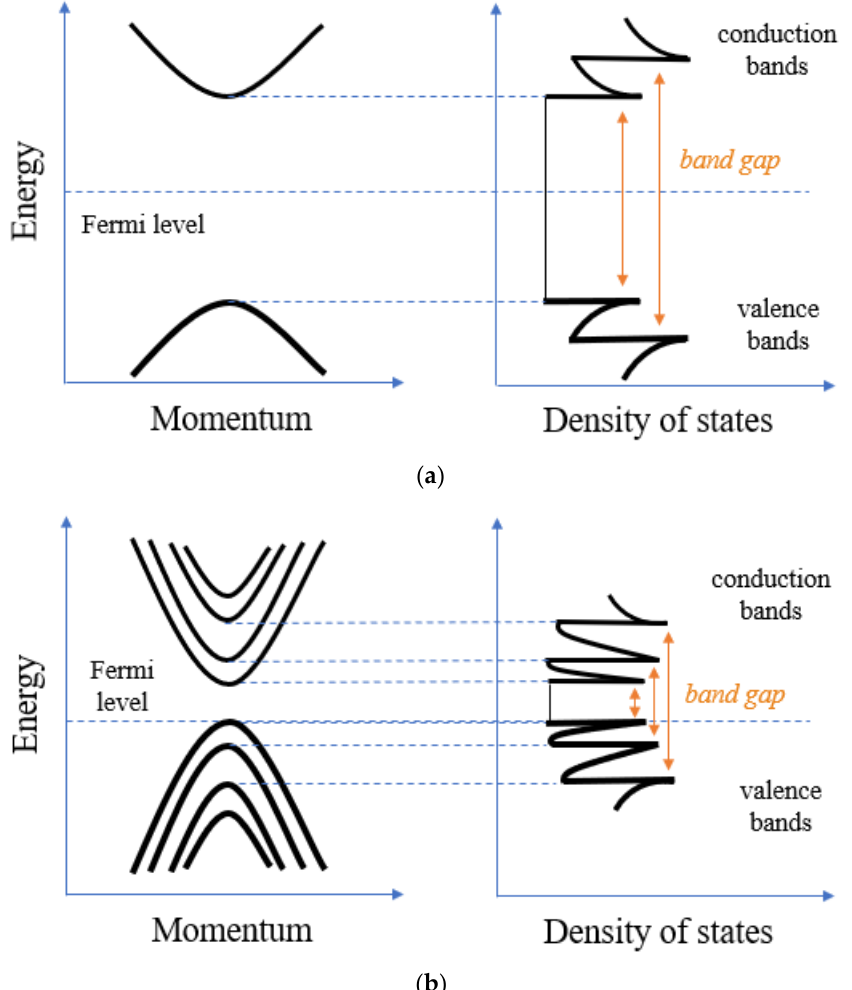
Figure 4. Idealized models of band structures and density of states for ( a ) metallic and ( b ) semiconducting nanotubes.